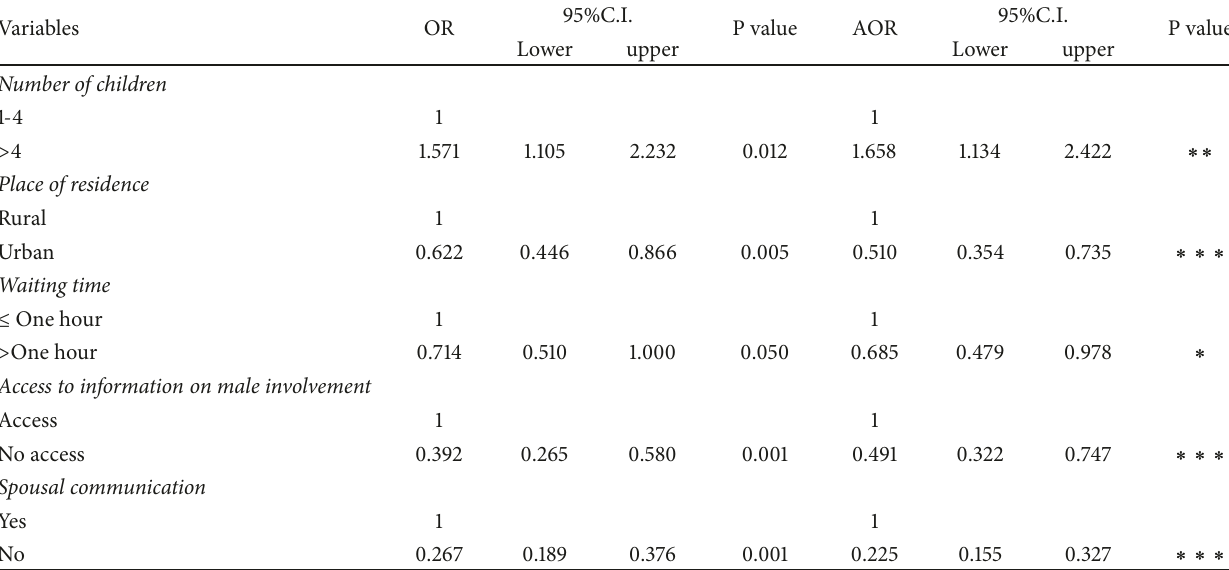
Table 5: Determinants of men’s involvement in maternity care